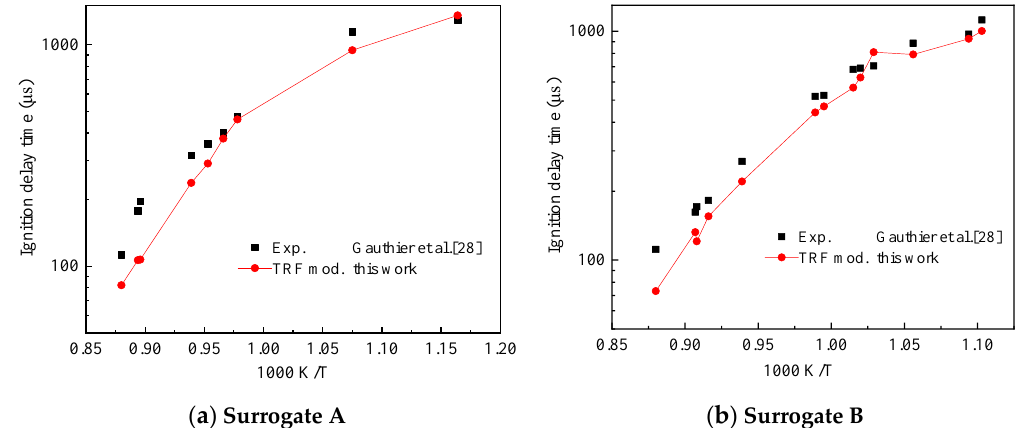
Figure 10. Comparison of experimental and toluene reference fuel (TRF) submechanism validation results on ignition delay times, ( a ) Surrogate A, ( b ) surrogate B.